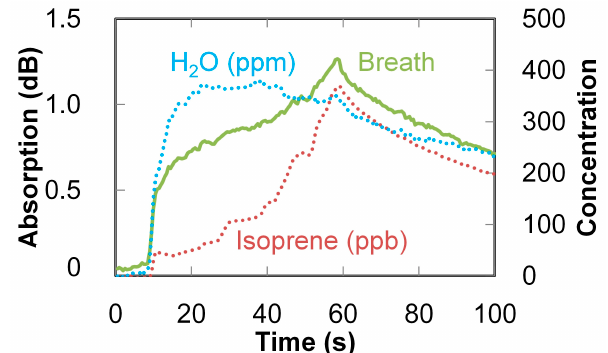
Figure 11. Change in the absorption at 215 nm compared with changes in concentrations of isoprene and water vapor.